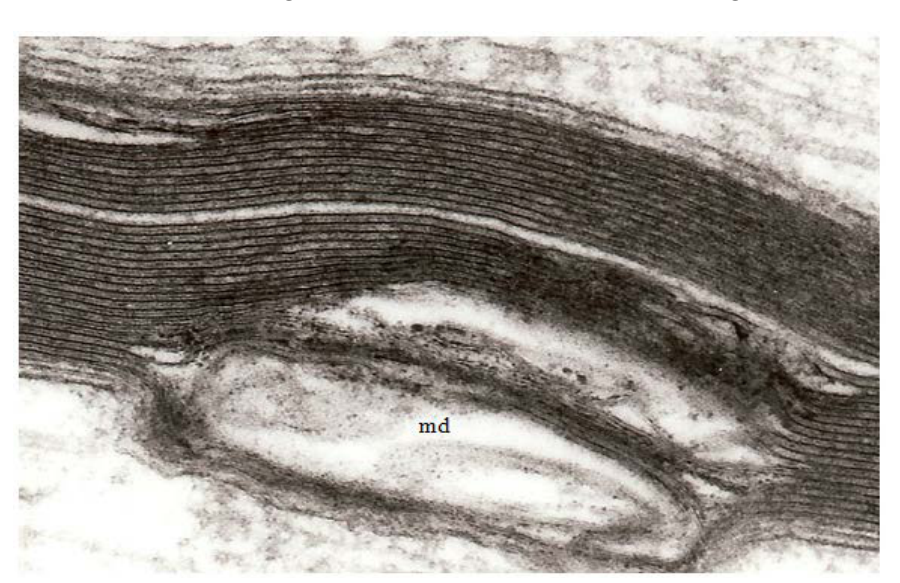
Figure 3. A high magnification field of parts of the myelin sheaths of two adjacent nerve fibers obtained at 2 h after stretch-injury to an optic nerve in an adult guinea pig. In the upper segment of myelin the alternating major dense and interperiod lines may be readily resolved. In the lower myelin segment a myelin discontinuity (md) is present at a site of separation of myelin lamellae. Some myelin membrane portions follow an irregular course through the md but retain a recognizable bilaminar ultrastructure. Magnification